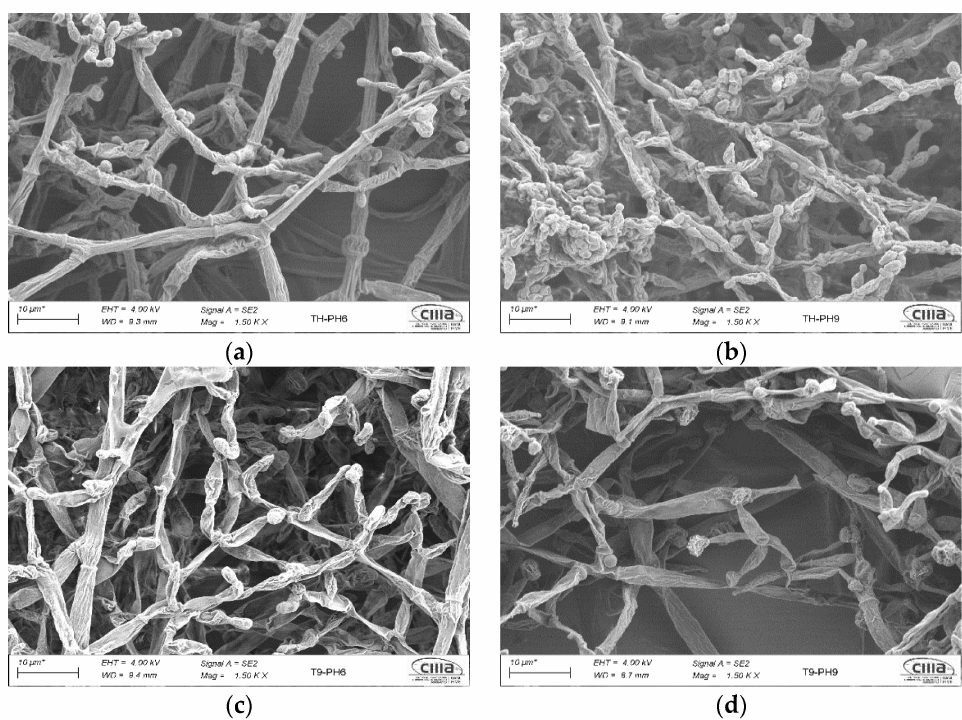
Figure 3. Scanning electron microscopy (SEM). Photomicrographs of ( a ) T. harzianum grown in MS + S (control pH of 6.0), ( b ) a stress condition with a pH of 9.0, ( c ) T9_UANL growth in MS + S (control pH of 6.0), and ( d ) a stress condition with a pH of 9.0 at 28 ◦ C for 72